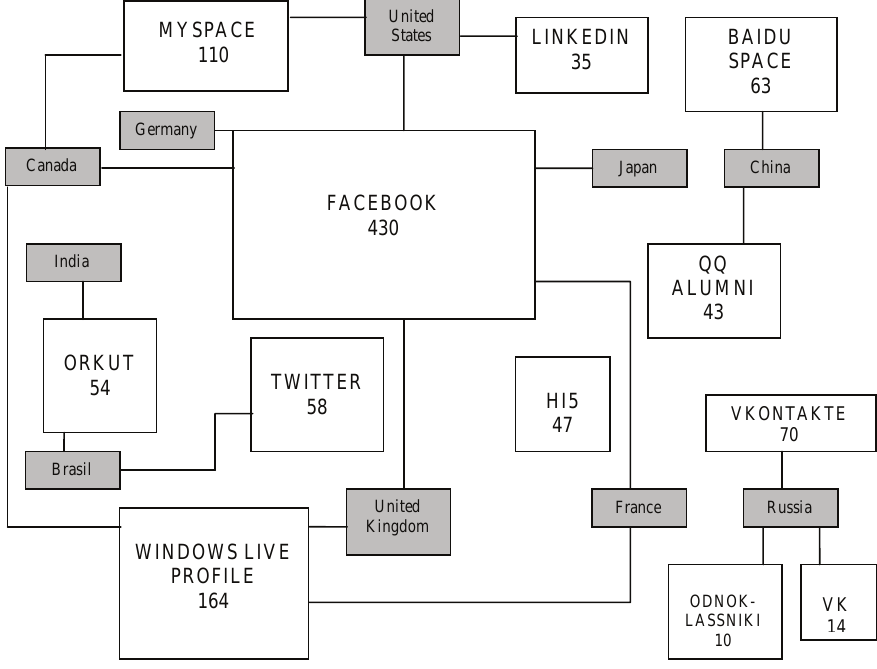
fig. 1. Visitors of socials networks via home and office computers in October 2009 (million users) (adapted from Uberti, Henriquez